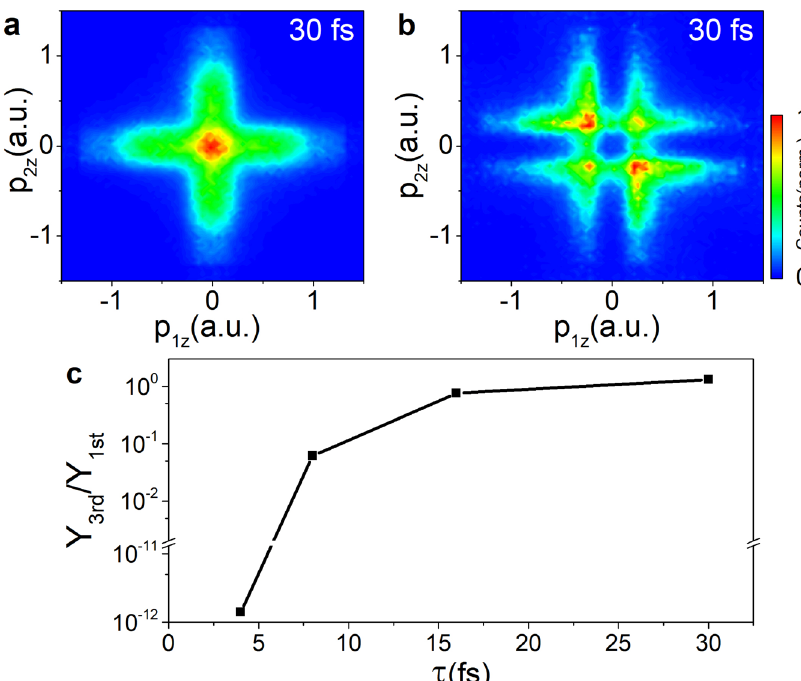
Fig. 4 Distributions corresponding to the fi rst- and third-return trajectories of e 1 . a Correlated electron momentum distributions (CEMDs) corresponding to the fi rst return. b CEMDs corresponding to the third return. c Pulse-duration dependence of Y 3rd / Y 1st , the ratio of the integrated yield of the third-return to that of the fi rst-return trajectories of e 1 . The laser intensity is 1.25 × 10 14 W cm − 2 . Each CEMD is normalized to itself. The carrier- envelope phases are